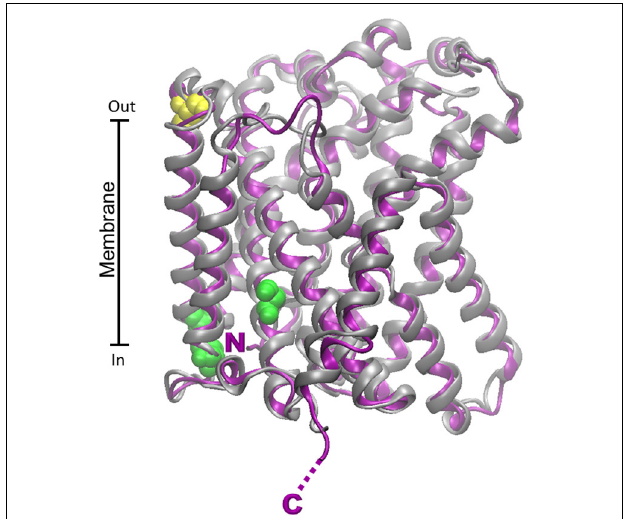
FIGURE 6 | Homology models of LAT2 human and rat transporters. The homology structural models of rat (Chaudhry et al.) and human (purple) LAT2 were constructed as described in Figure 4 using as template the structure of the arginine/agmantine antiporter AdiC from E. coli (PDB 3OB6). Superposition of the rat and human structural models was performed by VMD 1.9.1. C154 of the human protein involved in disulfide bridge with 4F2hc is highlighted in yellow; putative PKC and PKA phosphorylation sites are highlighted in green. N- and C- terminals of rat and human proteins are nearly coincident and highlighted by single N and